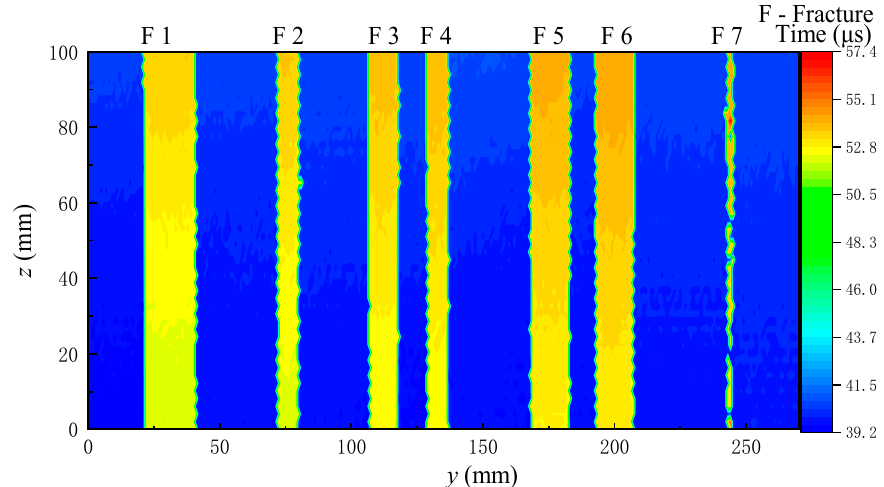
Figure 20. Echo arrival time imaging diagram for grooved sandstone Plate 2.